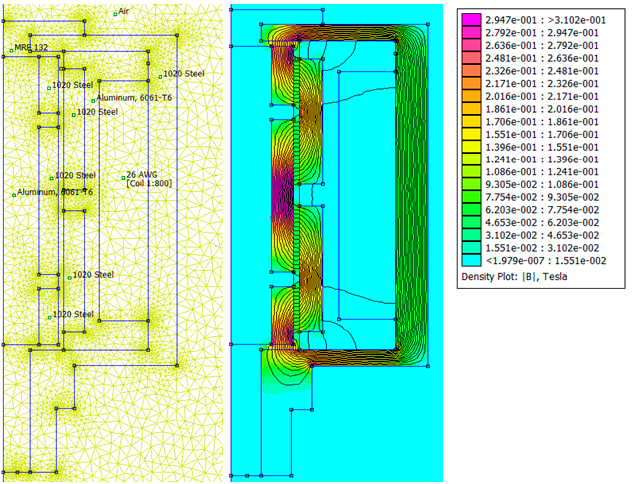
Figure 6. Magnetic analysis result using the finite element method.